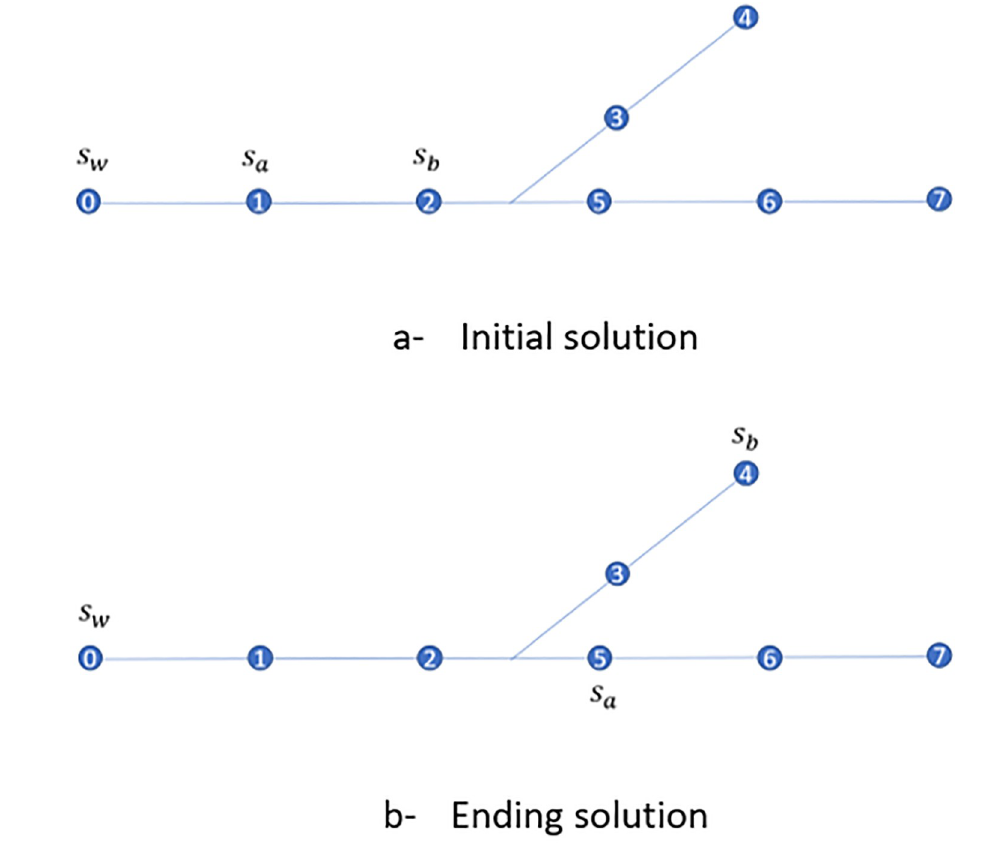
Fig 7. Initial and best solution of the sensor location problem example.